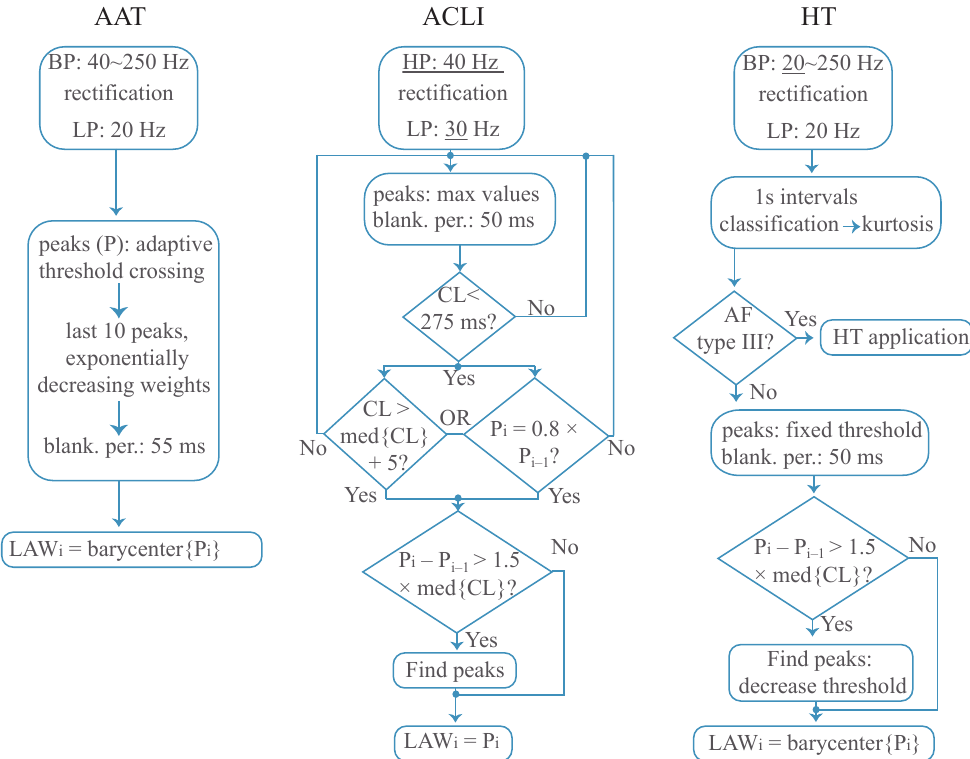
Figure 2. Block diagrams of the LAW detection methods compared. Underlined values in the first blocks show modified thresholds with respect to traditional Botteron’s preprocessing